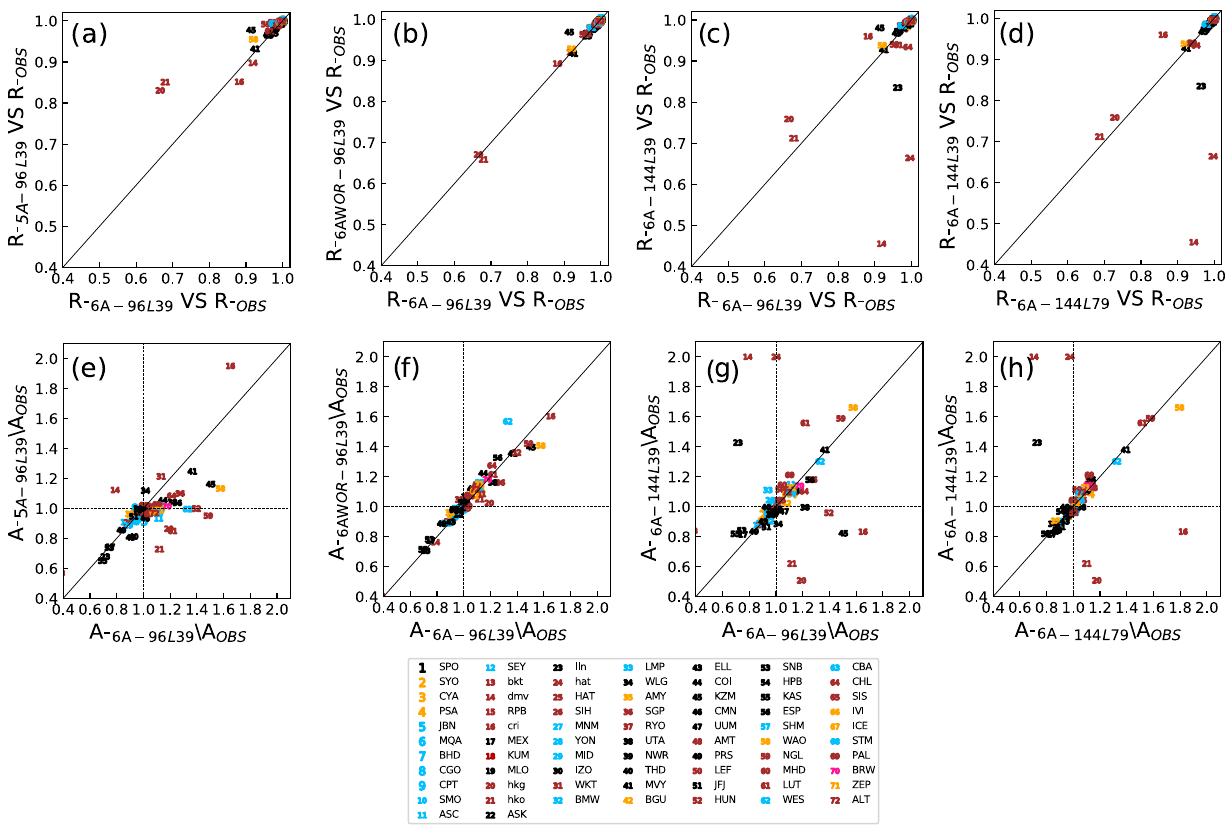
Figure 6. (a) Correlations between the observed and simulated CO 2 mean seasonal cycles from 6A-96L39 ( x axis) and 5A-96L39 ( y axis) for all available stations. (b–d) Same as (a) but from versions 6AWOR-96L39, 6A-144L39, 6A-144L79. (e) Ratio of the simulated to observed CO 2 seasonal amplitude from 6A-96L39 ( x axis) and 5A-96L39 ( y axis) for all available stations. (f) Same as (a) but from 6A-96L39 ( x axis) and 6AWOR-96L39 ( y axis). (g) Same as (f) but from 6A-96L39 ( x axis) and 6A-144L39 ( y axis). (h) Same as (f) but from 6A-144L39 ( y axis) and 6A-144L79 ( x axis). The stations are numbered by increasing latitude (with the identifier correspondence given in the bottom of the panel) and are coloured according to their category. Blue: maritime stations, black: mountainous stations, yellow: coastal station, brown: continental station. Stations written in lowercase (uppercase) refer to unassimilated (assimilated)